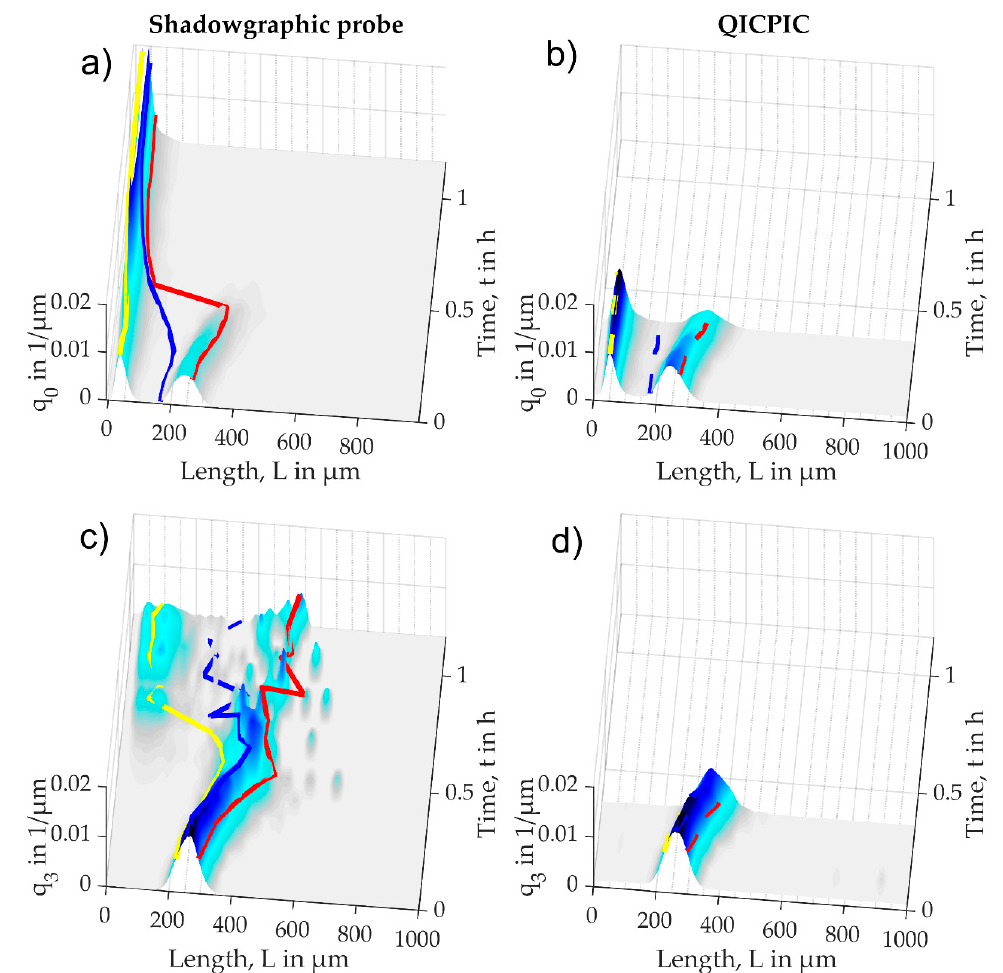
Figure 7. KH 2 PO 4 —Exp. 3 distributions ( a ) q 0 -distribution shadowgraphic probe; ( b ) q 0 -distribution QICPIC; ( c ) q 3 -distribution shadowgraphic probe; ( d ) q 3 -distribution QICPIC. Solid lines —percentiles of the shadowgraphic probe; Dashed lines —percentiles of the QICPIC; yellow and red − 0.15 and 0.85 percentile distribution; blue —transient mean sizes of the distribution.